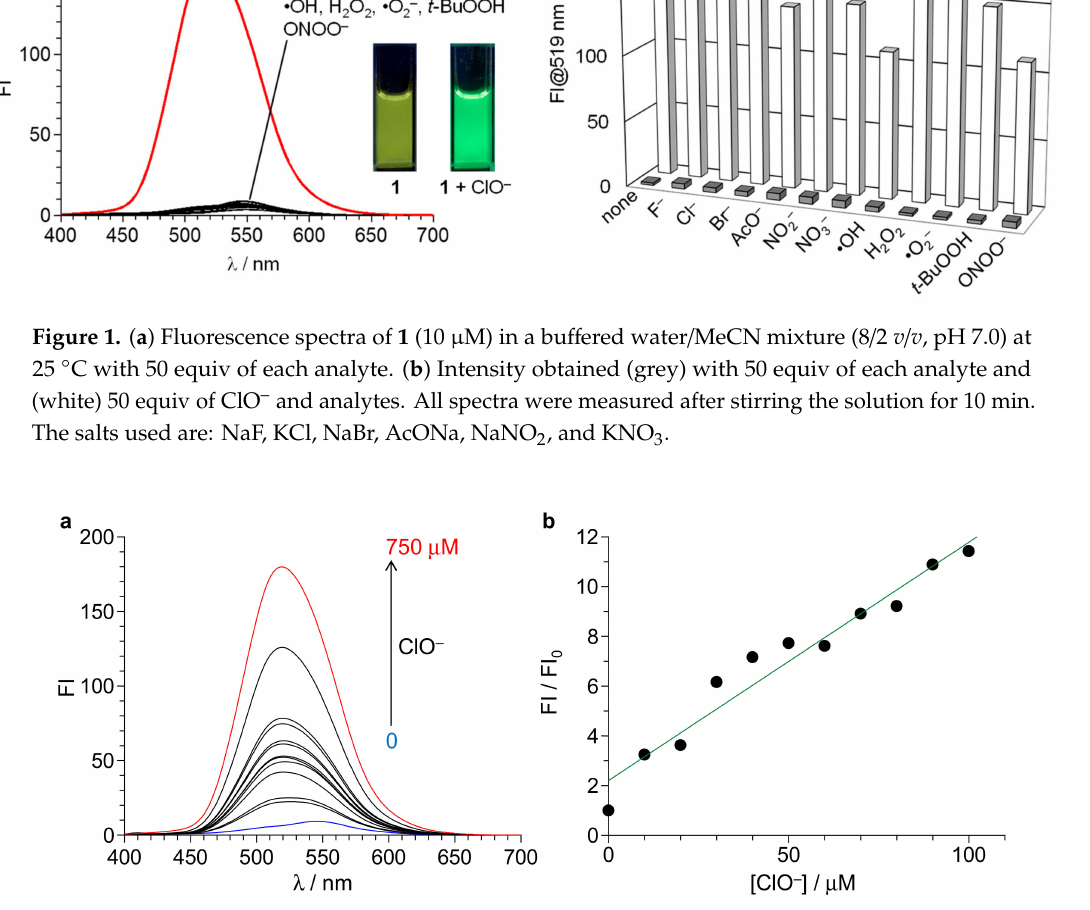
Figure 2. ( a ) Fluorescence spectra of 1 (10 µ M) upon titration with ClO − . ( b ) Plots of the intensity ratio at 519 nm versus the ClO −